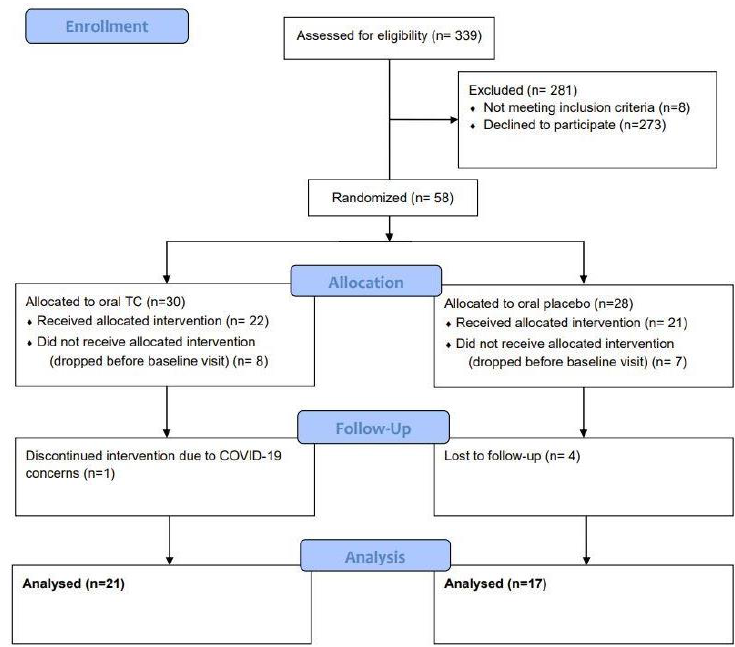
Figure 2. CONSORT Diagram.